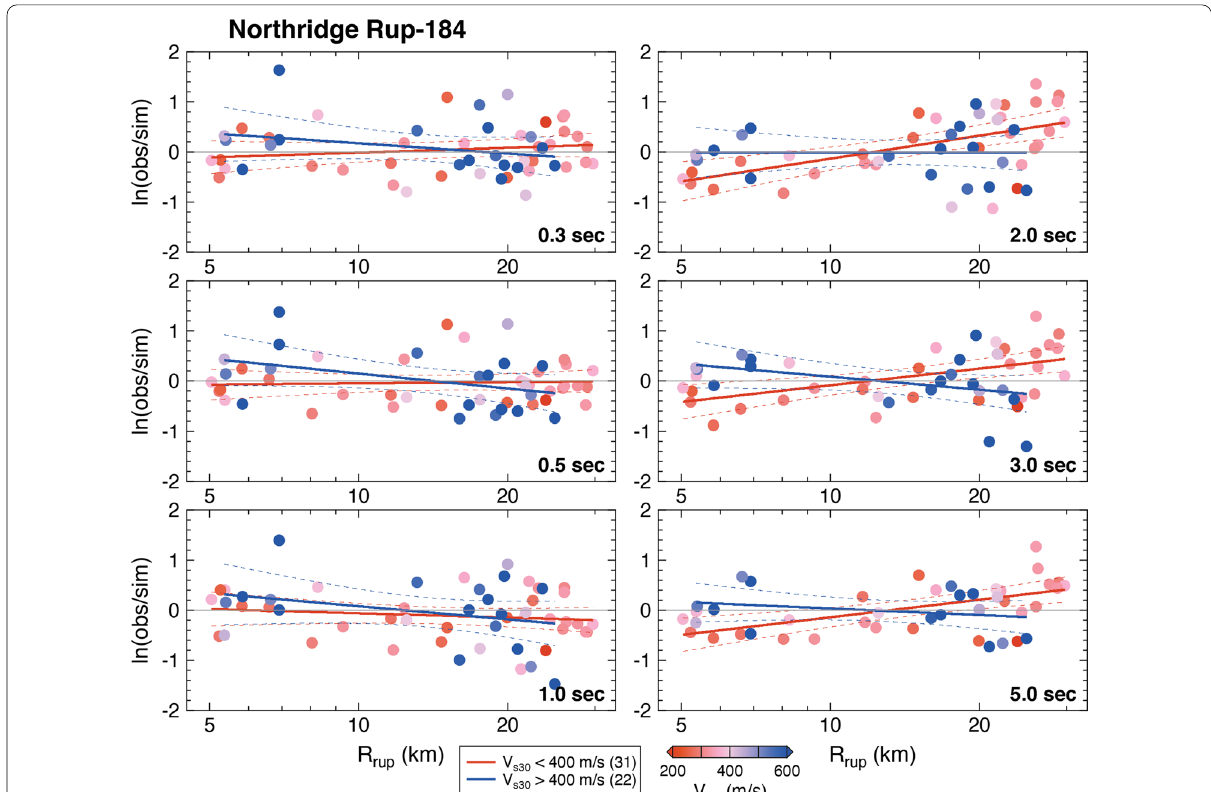
Fig. 8 RotD50 residuals for the Northridge simulation with the lowest | M | avg score plotted as a function of distance at six different oscillator periods. Oscillator period is shown at the lower right of each panel. Symbols are color-coded to the site V s30 value with blue-shading for the 22 sites having V s 30 > 400 m/s and red-shading for the 31 sites having V s 30 < 400 m/s. Least-squares fits with 95% confidence bounds are indicated by the solid and dashed lines, respectively, for each